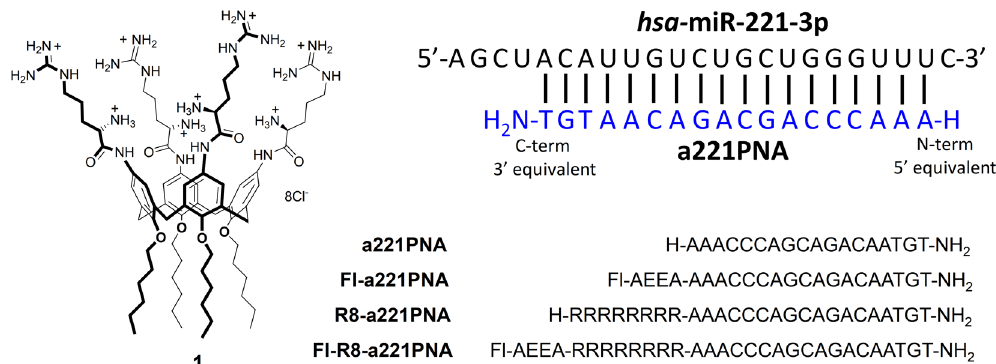
Figure 1. Structure of calix[4]arene 1 and sequences of the PNAs used in the present study. The PNA sequences are complementary to a tract of miR-221-3p as shown up on the right. Modifications at the N-terminus of a221PNA were performed linking the report unit and/or the octaarginine sequence. AEEA: 2-(2-aminoethoxy) ethoxyacetyl group, employed as spacer; Fl: